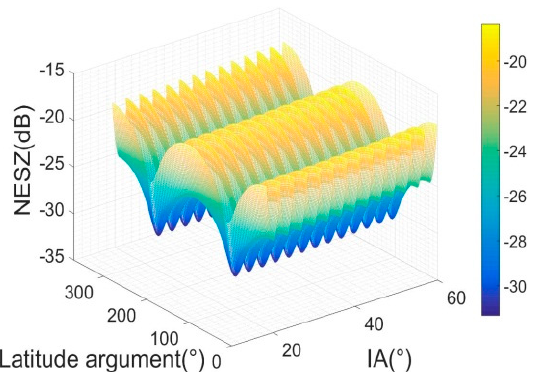
Figure 10. NESZ in whole orbit period and all incidence angle range.